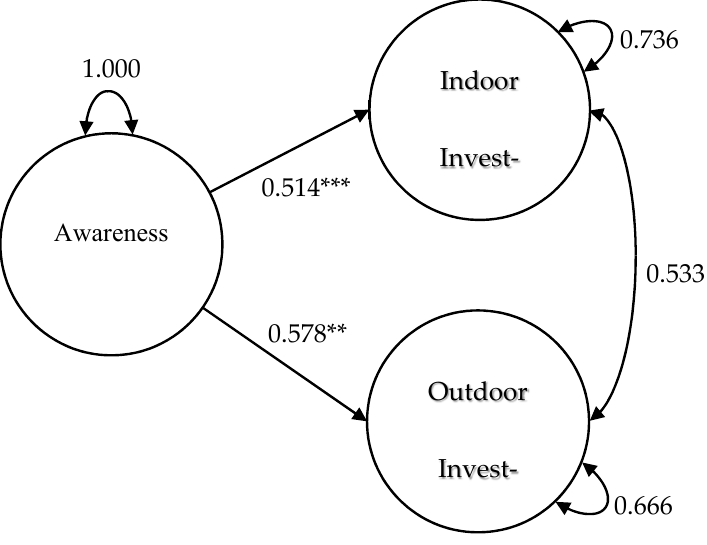
Figure 7. Model of owning water-saving appliances for indoor and outdoor usage regressed on awareness of water supplies for domestic well owners ( n = 145).